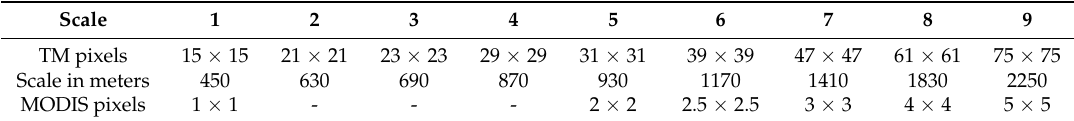
Table 2. Variogram estimating scales selected in this